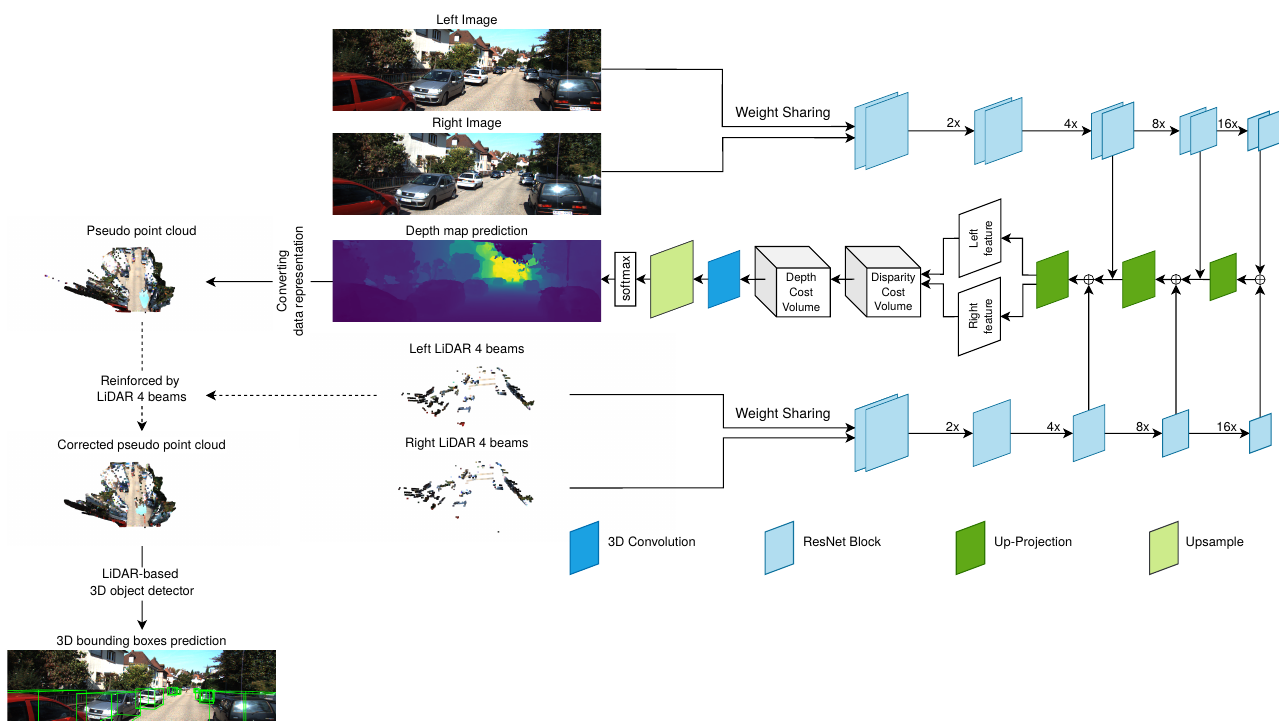
Figure 3. Overview of the SLS-Fusion framework. The model takes stereo images ( I l , I r ) and the corresponding simulated stereo images by projecting 4-beam LiDAR, for the left and right side ( S l , S r ). S l and S r are simulated using the formula proposed in [68]. An encoder-decoder network is used to extract features from both images and point clouds. The proposed network has a weight-sharing pipeline for both LiDAR and images, ( I l , S l ) and ( I r , S r ), instead of only using left and right images as proposed in [68,69]. Once the left and right features are obtained from the decoding stage, they are passed to the Depth Cost Volume (DeCV) proposed in [68] to learn the depth information. Here, as in [68], the smooth L 1 loss function is used: